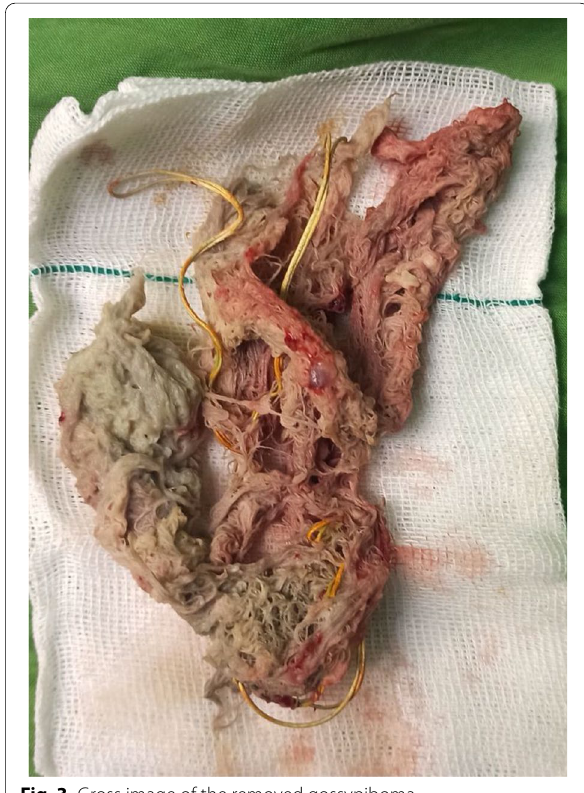
Fig. 3 Gross image of the removed